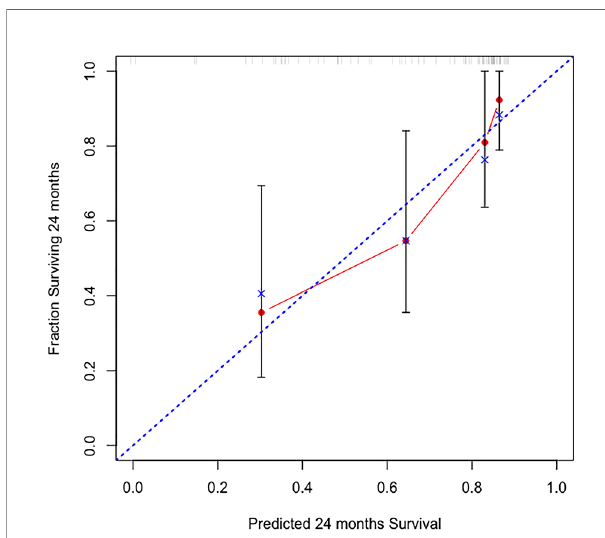
FIGURE 1 | Calibration plot of observed proportion versus predicted probability of 2-year biochemical recurrence after radical prostatectomy by the PSMA-ligand PET/CT-based risk